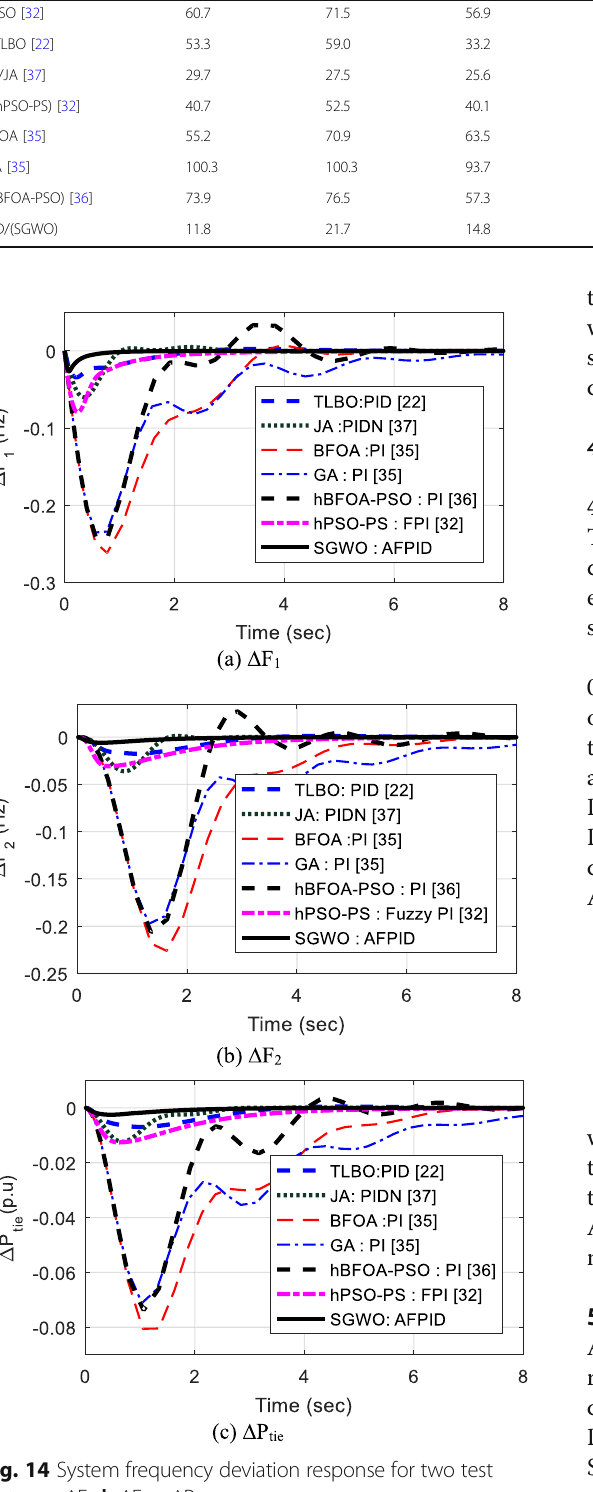
Table 10 Performance table for a two-area thermal power system at Δ P D1 = 0.05puMW (5%SLP) Controller/ Technique